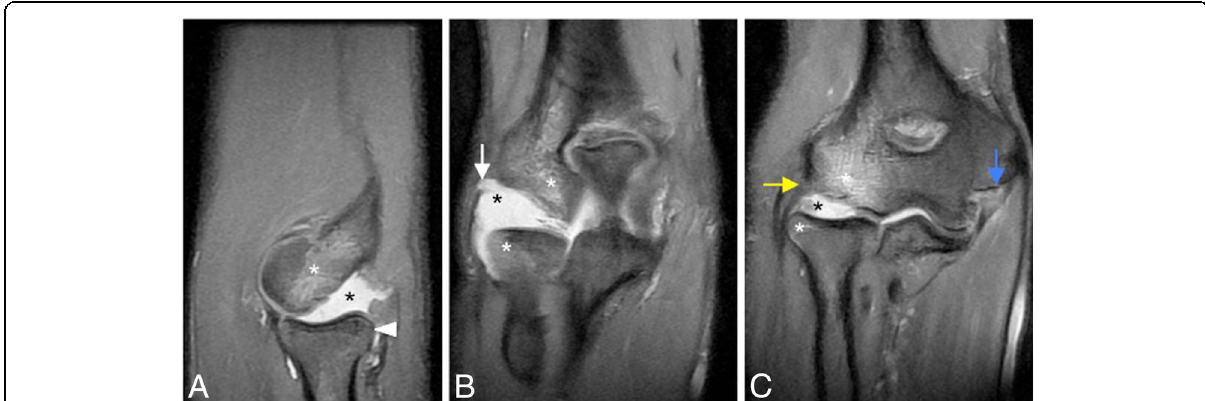
Fig. 30 Posterolateral rotatory instability, stage 3B. Sagittal FS PD-weighted MRI ( a ) and consecutive coronal FS PD-weighted MRI ( b , c ) showing a posterolateral subluxation of the radial head (white arrowhead), proximal disruption of the lateral ulnar collateral ligament (white arrow), partial proximal disruption of the radial collateral ligament (yellow arrow), proximal disruption of the anterior bundle of the medial collateral ligament (blue arrow), radial head and posterior capitellar contusions (white asterisks), and joint effusion (black asterisks)